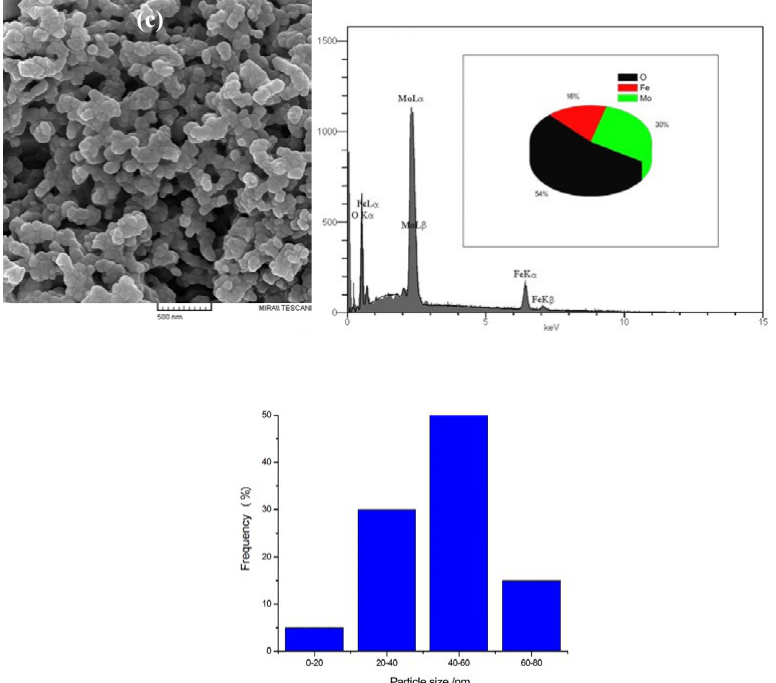
Fig. 1: SEM images of (a) Fe-MoI, (b) Fe-MoII and (c) Fe-MoIII and EDX accomplished by the size distribution histogram of the prepared